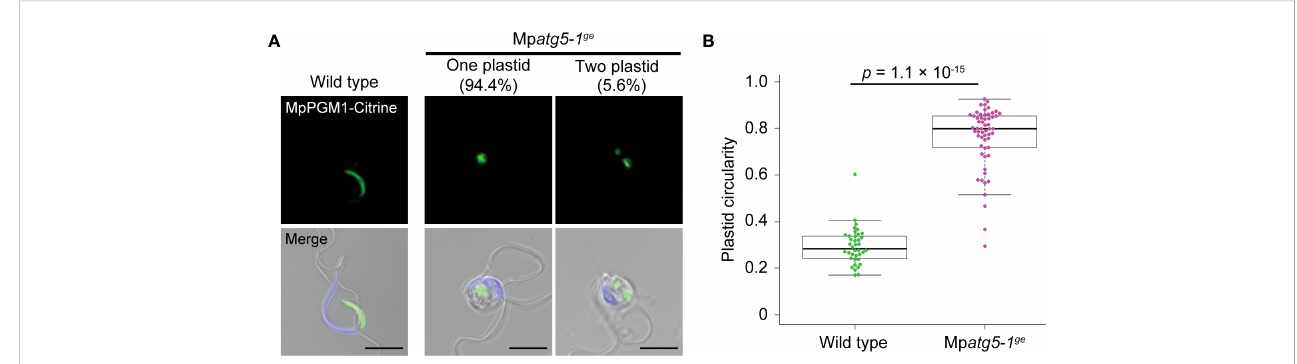
FIGURE 2 Impaired morphological changes of the plastid in the autophagy-defective mutant. (A) Confocal images of wild-type and Mp atg5-1 ge spermatozoids expressing MpPGM1-Citrine (green). The nuclei were stained with Hoechst 33342 (blue). Scale bars = 5 m m. A total of 38 wild-type and 54 Mp atg5-1 ge spermatozoids were observed and representative images are presented. (B) The circularity of the plastid was calculated using the same set of samples analyzed in (A) . The boxes and solid lines in the boxes indicate the fi rst and third quartiles and the median, respectively. The upper and lower whiskers are drawn at the greatest value smaller than 1.5× the IQR above the third quartile and the smallest value greater than 1.5× the IQR below the fi rst quartile, respectively. The p values obtained using the Wilcoxon rank-sum test are